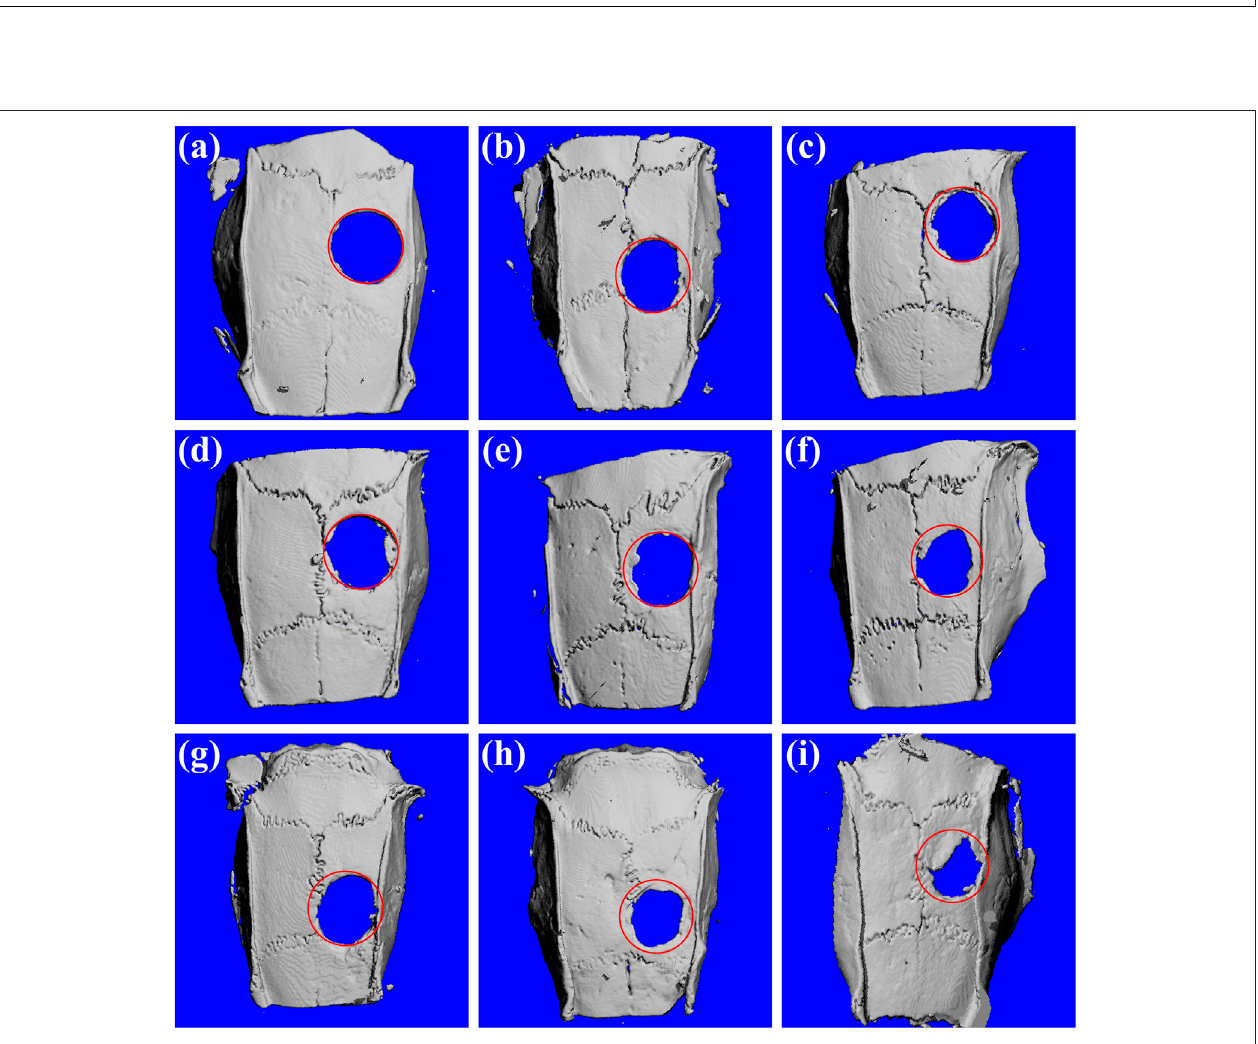
FIGURE 6 | Micro-CT images of the rat skulls 1, 2, and 3 months after the surgery. (A) Control group, 1 month; (B) Control group, 2 months; (C) Control group, 3 months; (D) PAM-SA hydrogel group, 1 month; (E) PAM-SA hydrogel group, 2 months; (F) PAM-SA hydrogel group, 3 months; (G) Composite hydrogel group, 1 month; (H) Composite hydrogel group, 2 months; (I) Composite hydrogel group, 3 months.